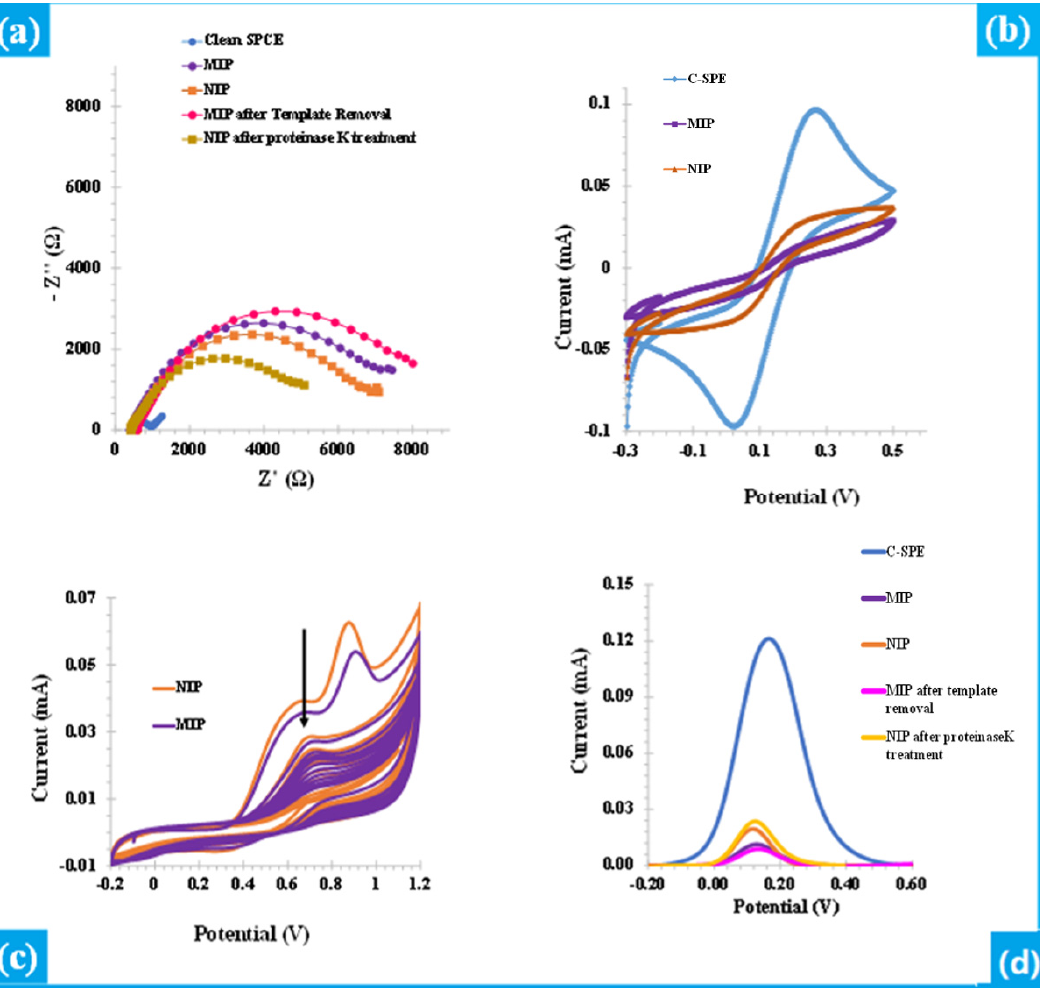
Figure 2. Follow up of the different steps for MIP and NIP films ( a ) EIS data ( b ) CV data ( c ) electrochemical polymerization of MIP and NIP film at C-SPEs (10 cycles) and ( d ) SWV data. The standard iron redox probes were 5.0 mM [Fe(CN) 6 ] 3 − and 5.0 mM [Fe(CN) 6 ] 4- solution in PBS buffer pH